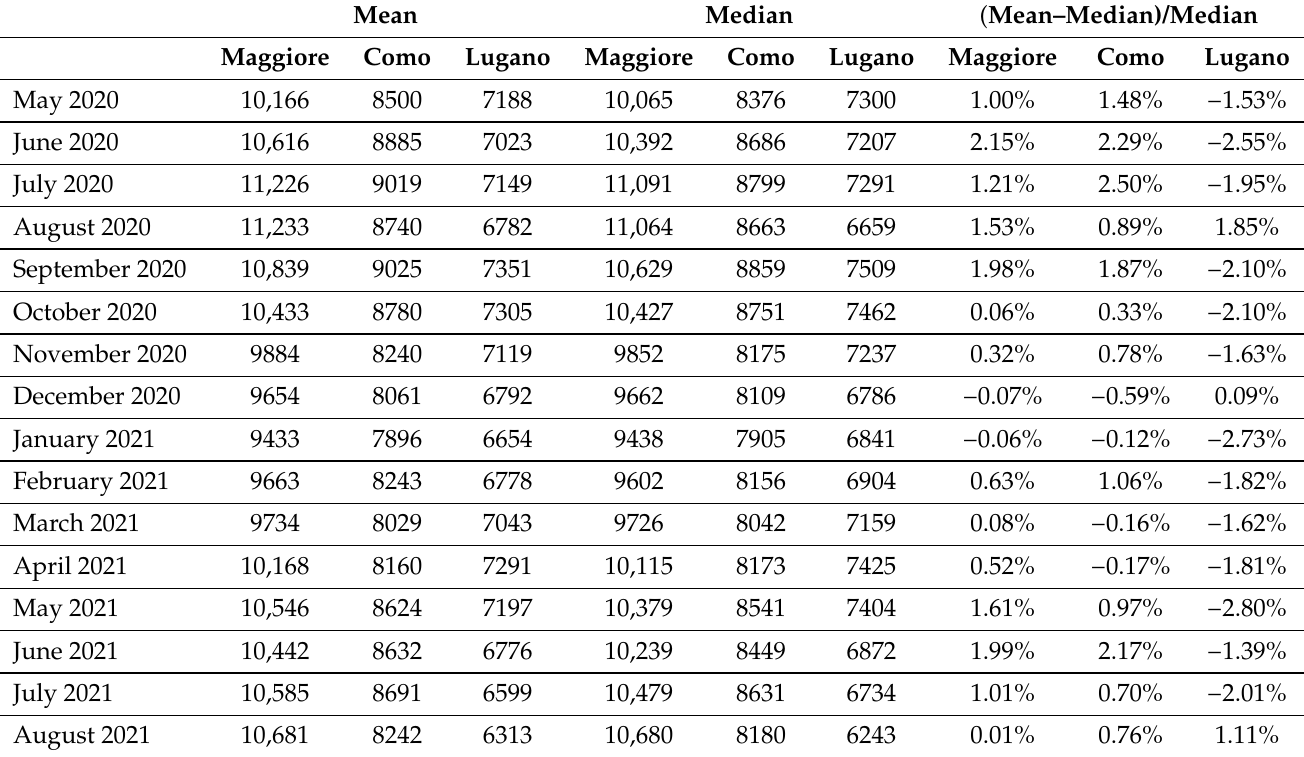
Table 3. Monthly mean and median values of the Facebook users’ counts by lake areas. Relative differences [%] between the two statistics are normalised by using the medians as a